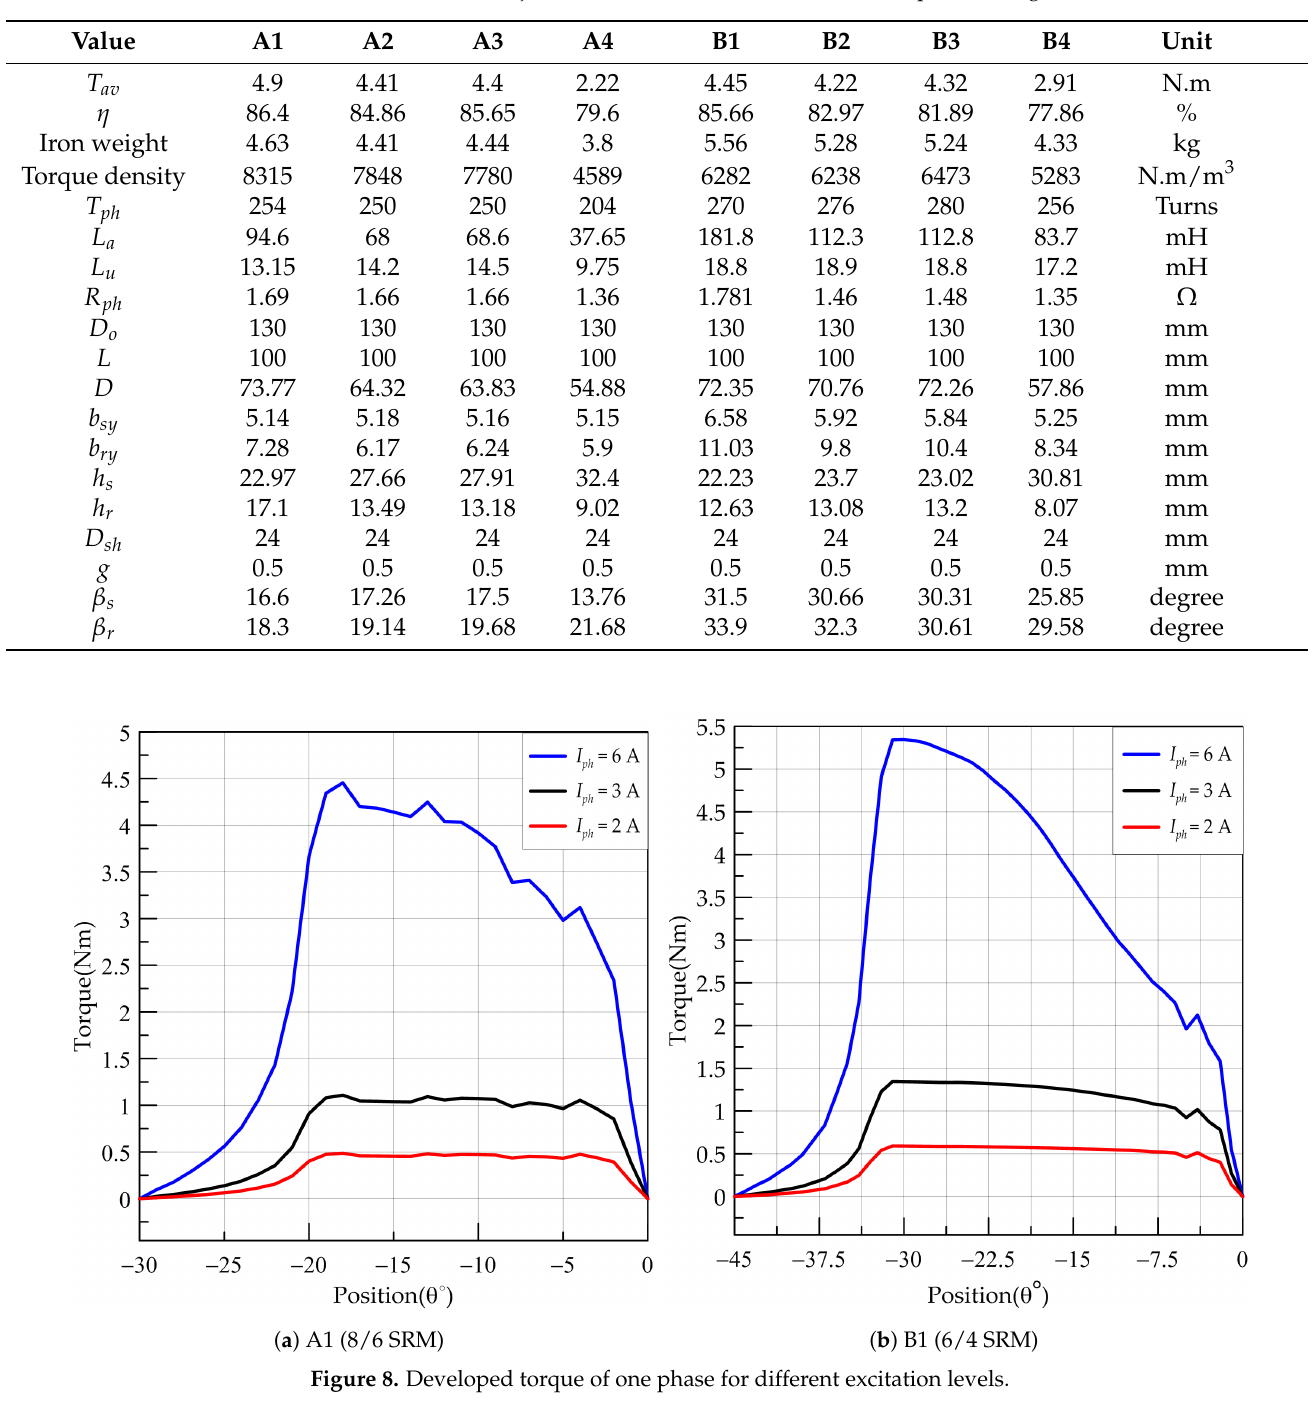
Table 5. Parameters and objective functions values of the selected optimal designs.